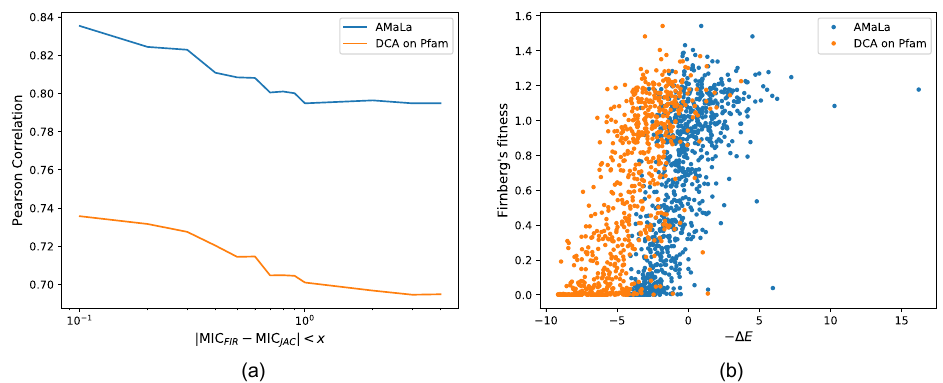
Figure 1. Correlation between inferred energies and fitness measurements realized in [7]. Such measurements are preliminarily mapped over [4] data following the same procedure proposed in [32]. As a consequence of this mapping, the overlap of the sequences appearing in both [26] and the testing dataset amounts to just two. Furthermore, it is also possible to filter out the noisiest data, retaining only those measurements displaying a low discrepancy between the two datasets. Panel ( a ) shows the trend of the Pearson correlation obtained as a function of this discrepancy threshold. Namely, correlations are referred to as energies inferred over Fantini’s dataset [26] via AMaLa (blue line) and over PFAM PF13354 via PlmDCA (orange). More specifically, such energies are previously mapped over fitness scores via the same procedure exploited to map [7] into [4]. This strategy allows expressing the correlation performance in terms of a linear estimator rather than the more general Spearman coefficient. From the plot, it emerges how correlations increase by progressively excluding those measurements with the highest discrepancy among the datasets. Moreover, [26] measurements analyzed via AMaLa turn out to provide a better fitness estimator with respect to the homology family, characterized by a much more dispersed distribution of sequences. In panel ( b ), the scatter between the minus energies (not mapped) and the fitness measurements of [7] is reported, with a discrepancy threshold between minimum inhibitory concentrations equal to x = 1.0.